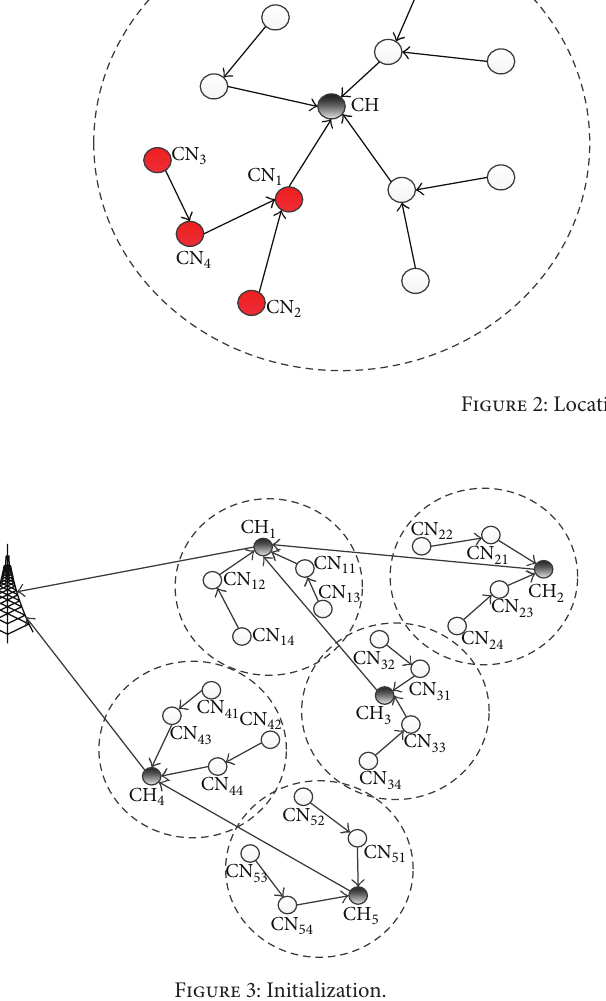
Figure 3: Initialization.